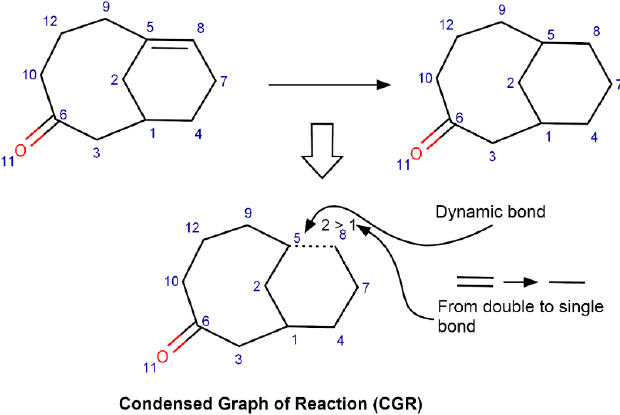
Figure 5. C ondensed Graph of Reaction (CGR) generation.